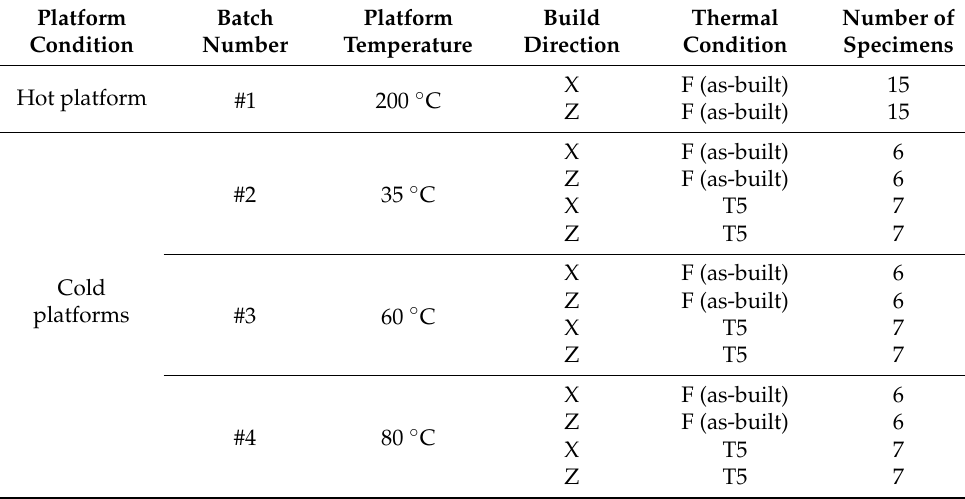
Table 2. Details of the batches of fatigue